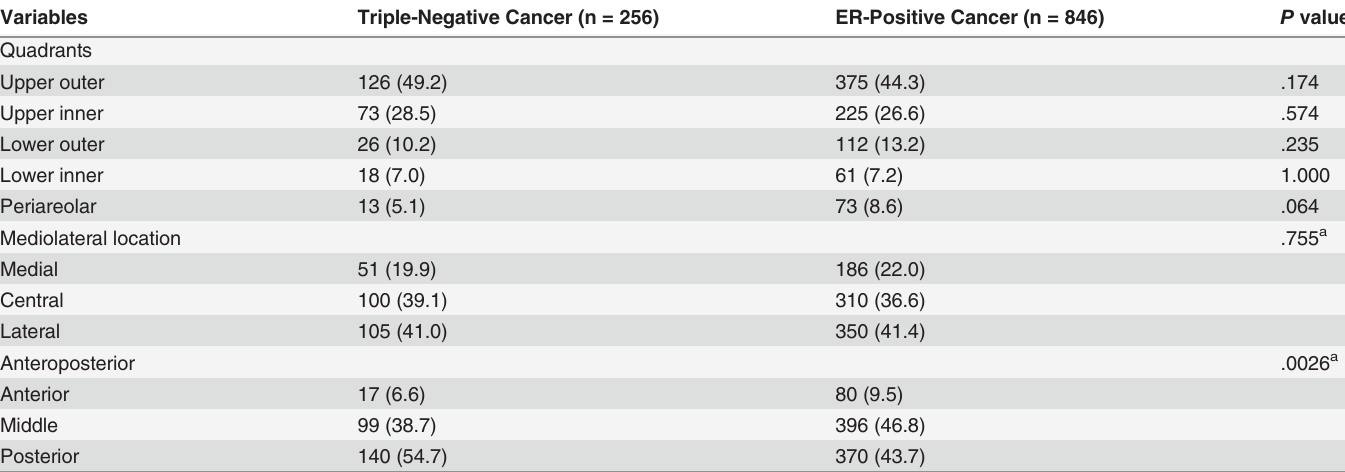
Table 2. Distribution of Tumor Location.